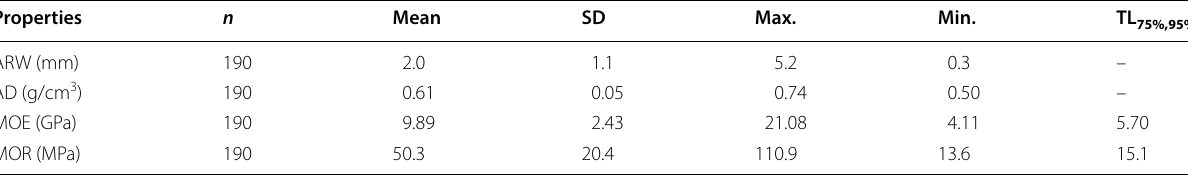
Values of the MOE and MOR were adjusted to those at 15% moisture content by the method of the Japan Housing and Wood Technology Center [28] n number of lumber pieces, ARW annual ring width, AD air-dry density at testing (moisture content at 12.7 rupture, SD standard deviation, Max . maximum, Min . minimum, TL 75%,95% , 5% lower limit with a 75% confidence level (5% tolerance limit)